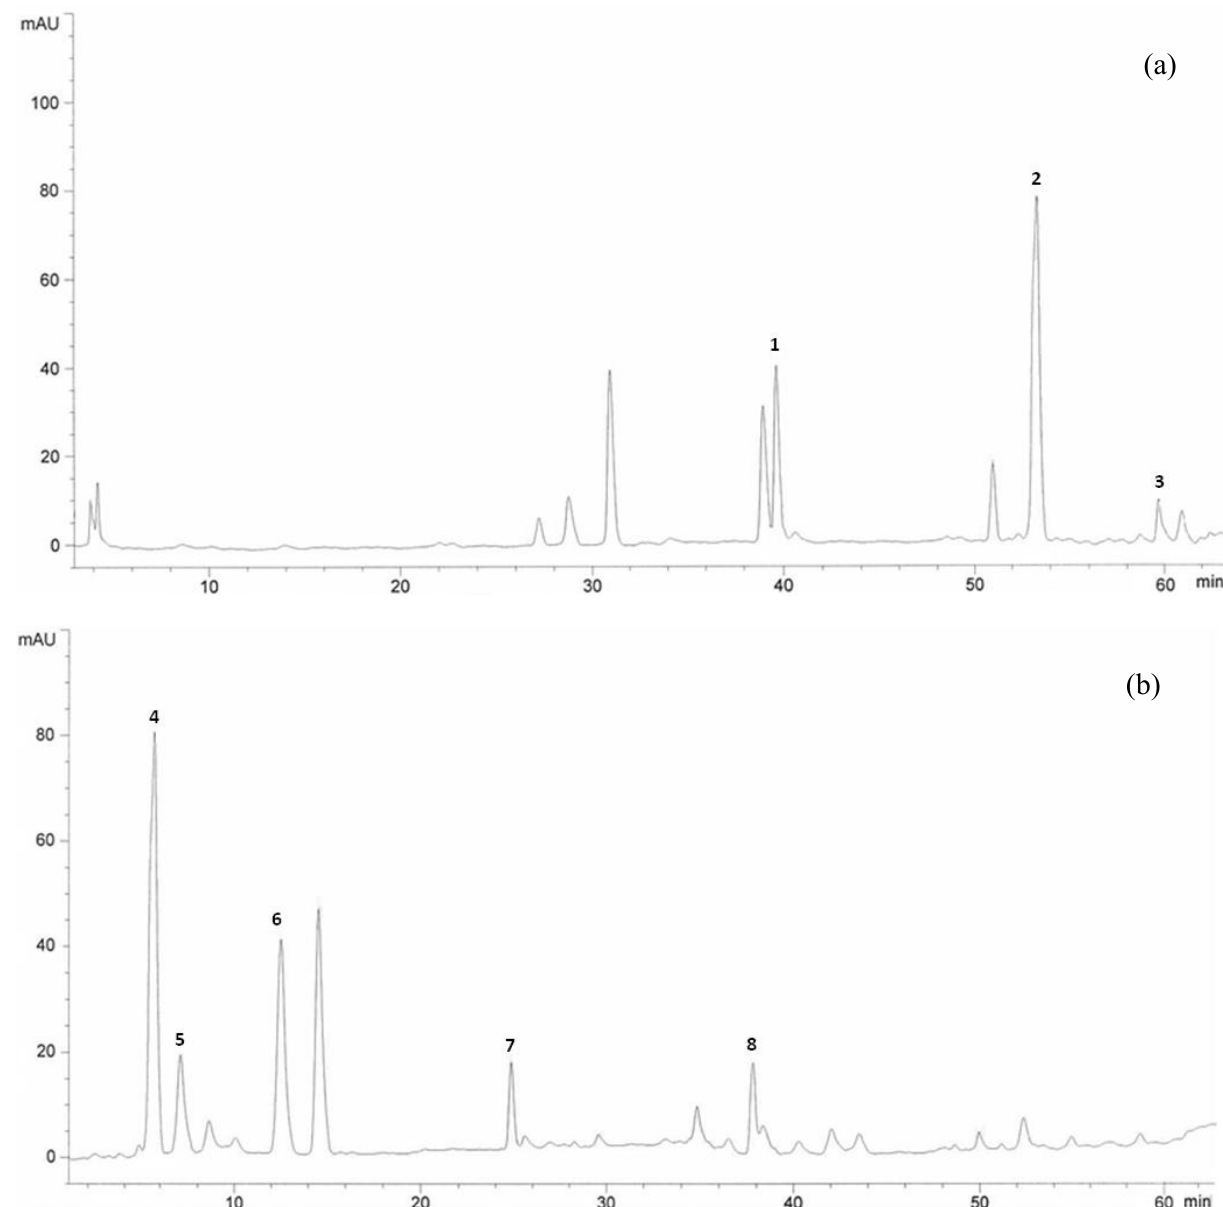
Figure 1. HPLC chromatogram of Halia Bentong ginger (Zingiber officinale) leaves extracts at wavelengths of 360 nm (a), and 280 nm (b). Identification of compounds: quercetin (1), rutin (2), kaempferol (3), fisetin (4), morin (5), catechin (6), epicatechin (7), naringenin